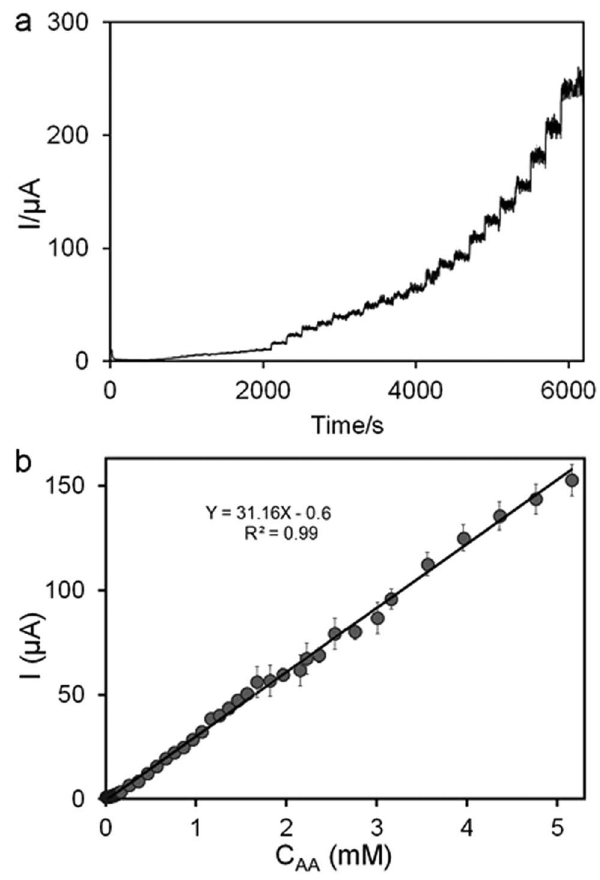
Figure 4: Calibration curve and amperometric responses ( linear range ) of the MeGO/PANI - functionalized biosensor for determining AA and investigating the surface redox reaction. Applied potential was + 0.8